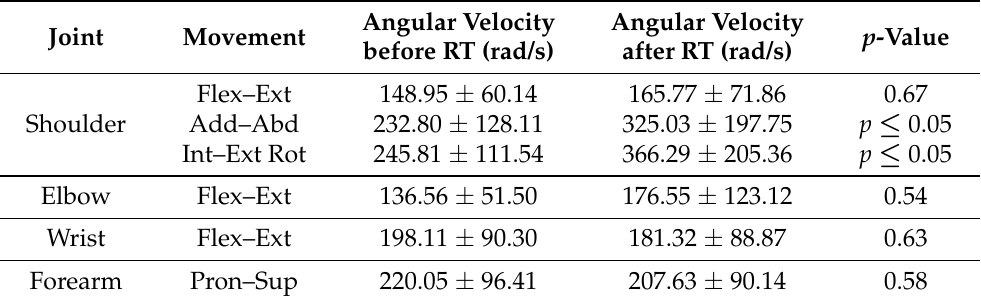
Table 7. Angular velocities obtained for the paretic limb in the Maximum Forward Reach Test before and after the rehabilitation therapy.